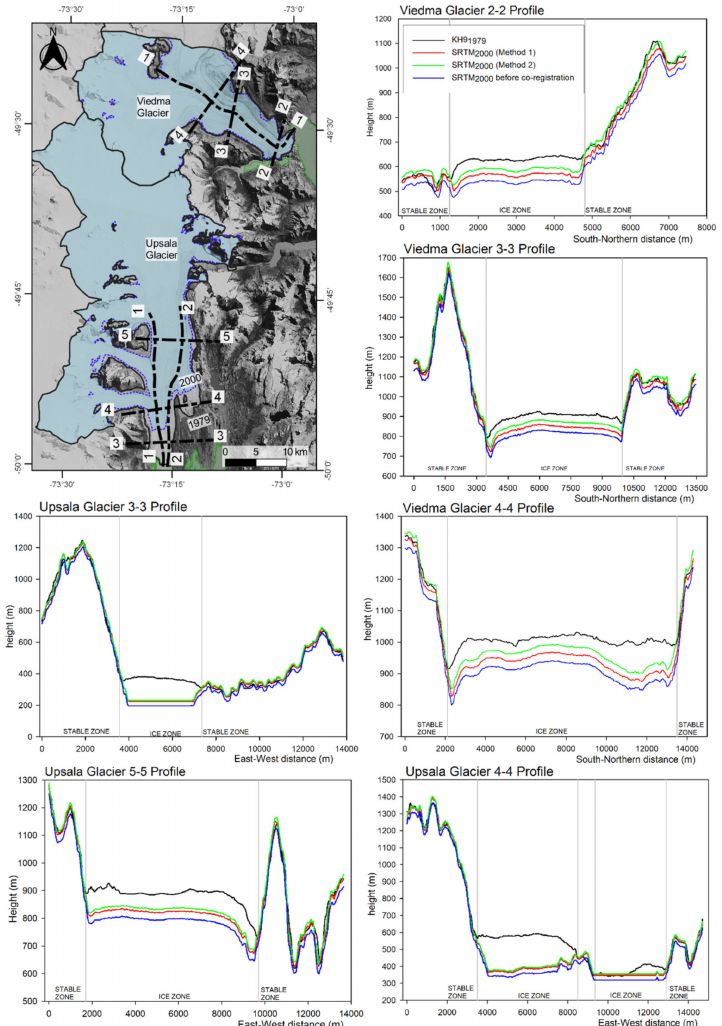
Figure 5. Upsala and Viedma transversal glacier profiles before and after the co-registration process using Method 1 and Method